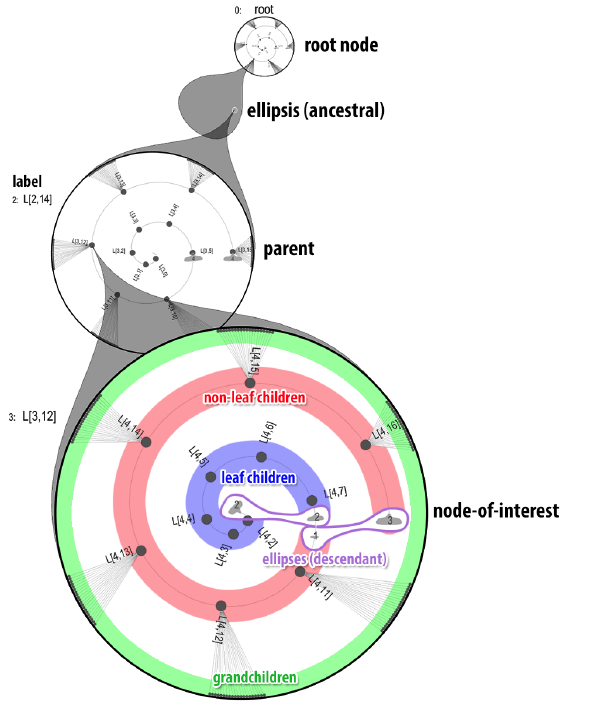
Figure 4. Visual organization of a PaisleyTree. In each node grandchildren are positioned on the perimeter of the circle. Non- leaf children on the outer ring of the spiral and leaf children are positioned on the inner ring of the spiral.